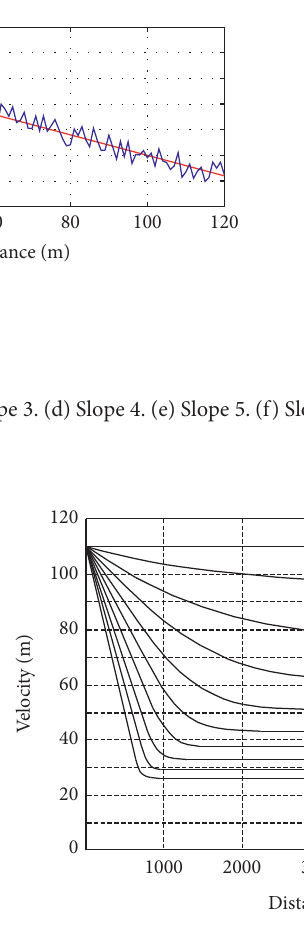
Figure 7: Velocity variation curves of uphill travelling under different longitudinal gradients in AASHTO Green Book